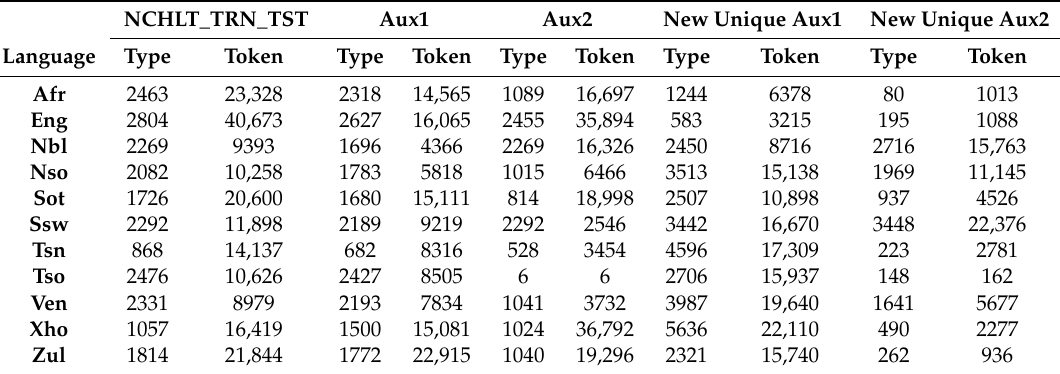
Table 3. Type and token counts for prompts in both NCHLT_TRN and NCHLT_TST. Aux1, Aux2: Type and token counts for prompts repeated in auxiliary data. New unique: Type and token counts for new prompts in Aux1 and